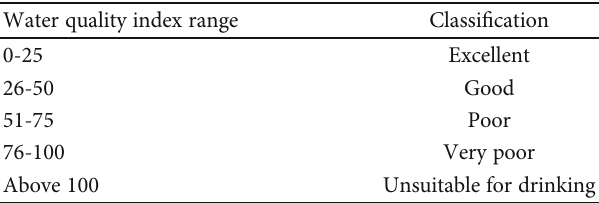
Table 3: Water quality classi fi cation (WQC) [42].